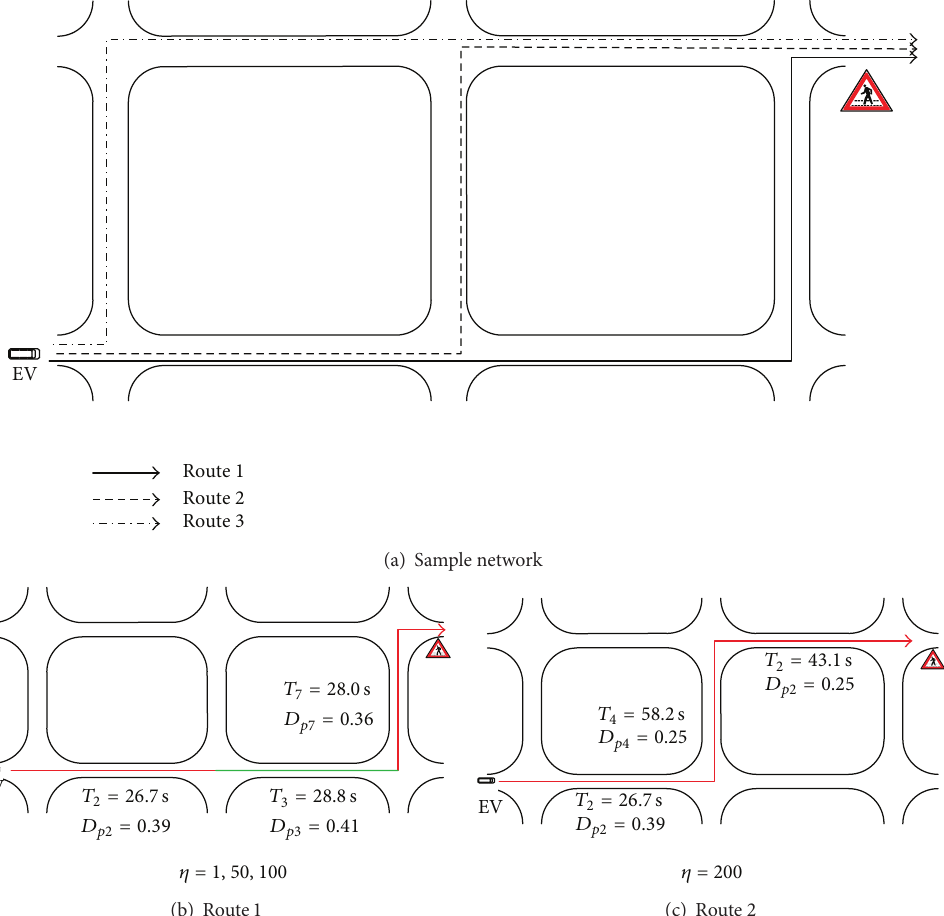
Figure 6: Sample network and selected emergency routes based on different 𝜂